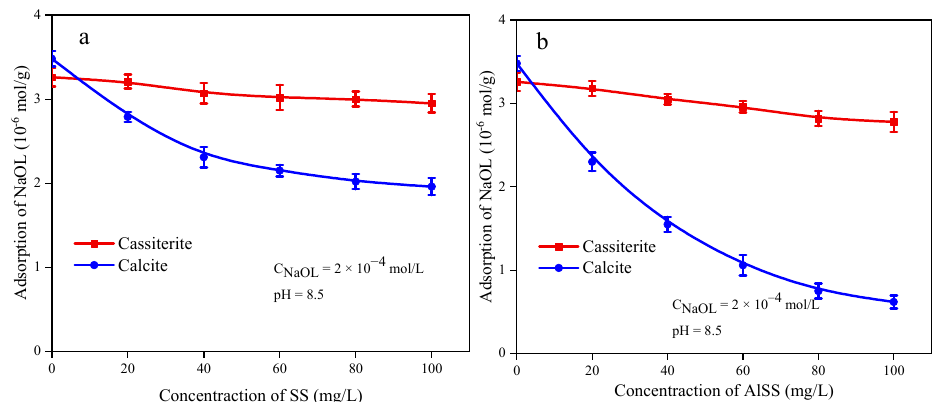
Figure 9. Amount of NaOL adsorbed on the surface of minerals as a function of the depressant concentration ( a ) SS and ( b ) AlSS.